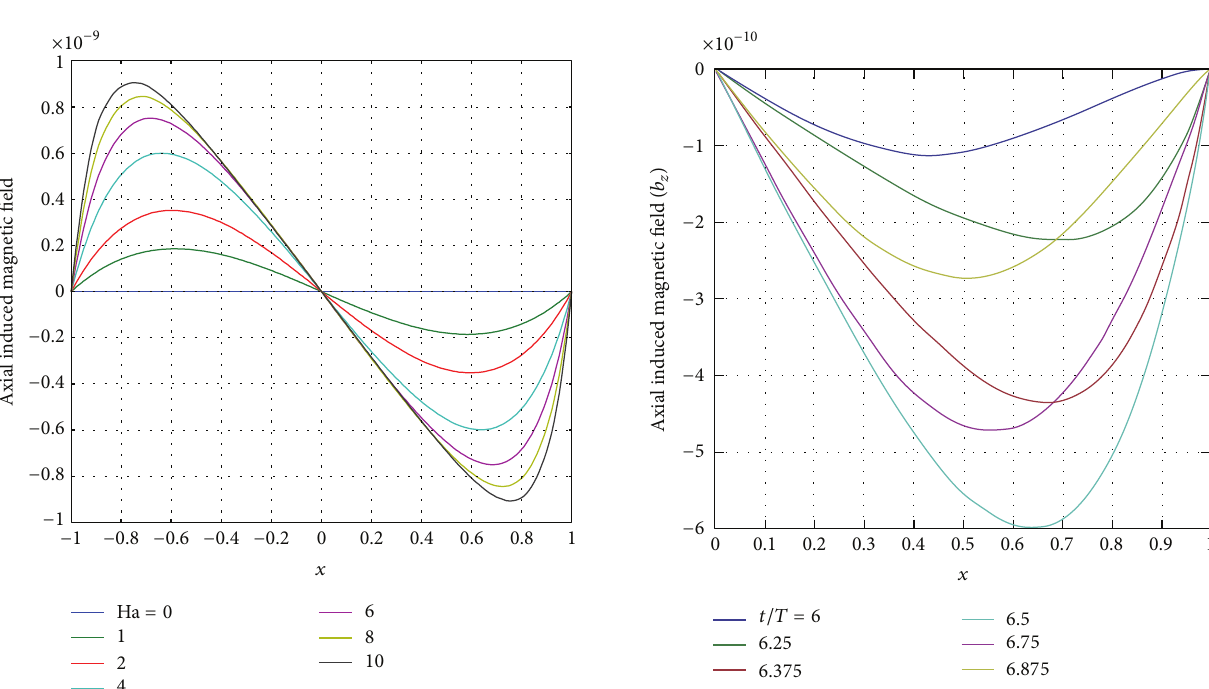
Figure 13: Axial induced magnetic field profiles for different Hart- mann number Ha in steady case for Re = 300 .